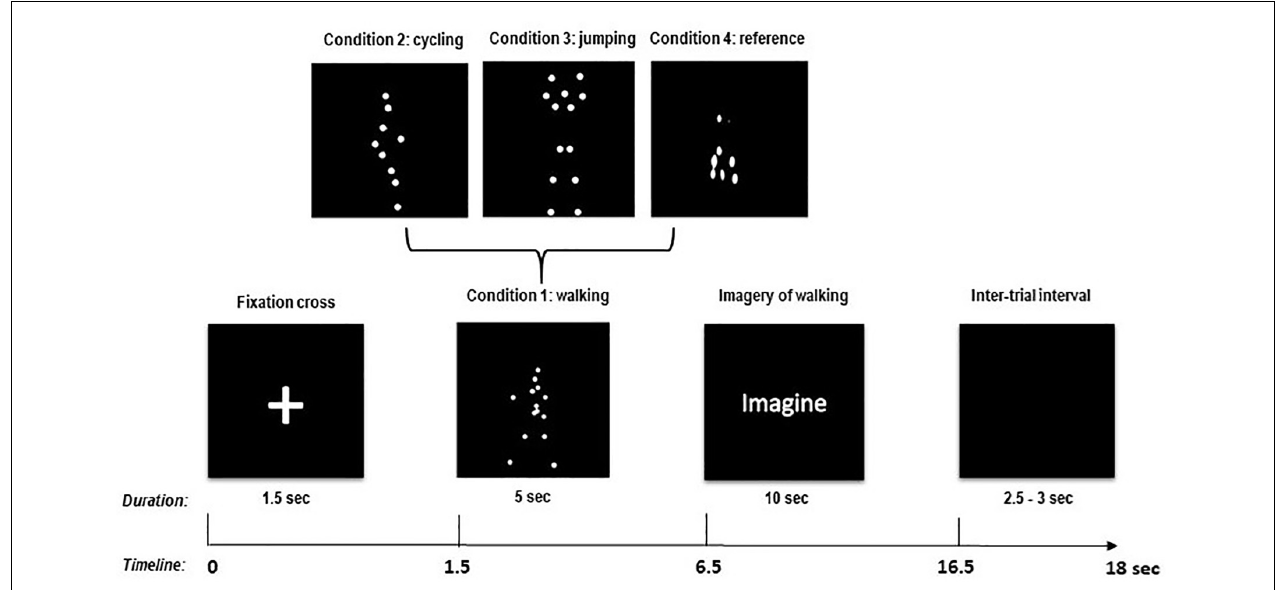
FIGURE 1 | Experimental paradigm and timing of one